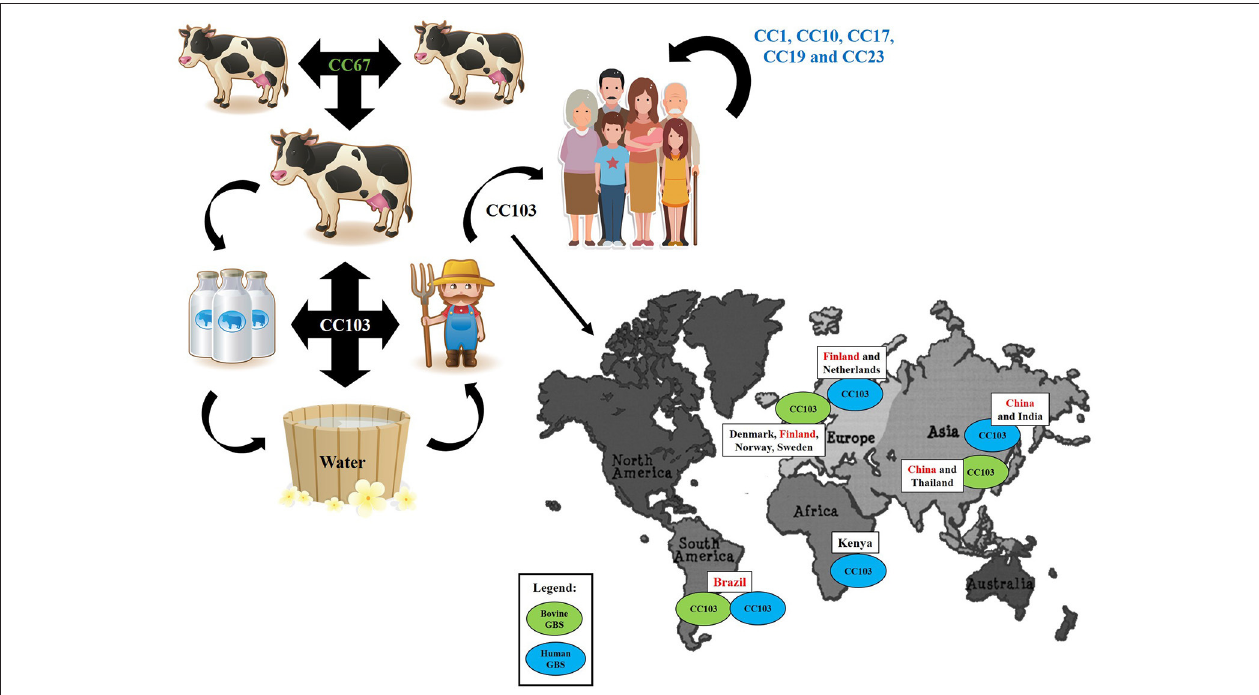
FIGURE 1 | An illustrative summary of the hypothesis raised in this opinion article, showing the clonal complexes (CC) mostly associated with each host and transmission route of Streptococcus agalactiae , and the distribution of CC103, one of the missing links between human- and bovine-adapted clones in the alternative transmission routes,